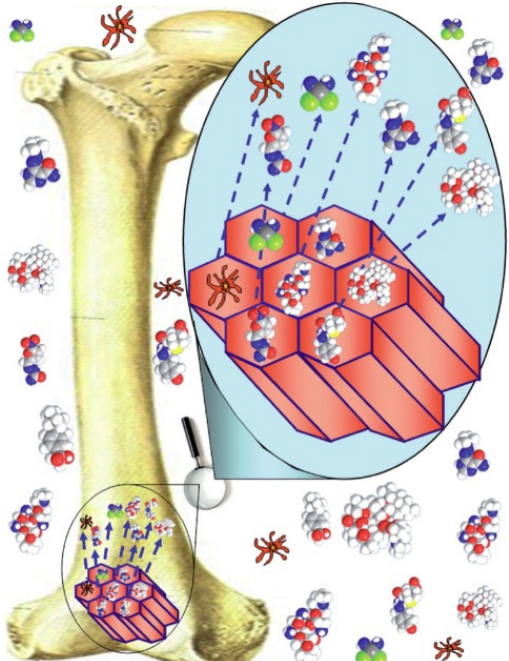
Figure 11. Schematic concept of using MBGs for drug delivery and bone regeneration [70].